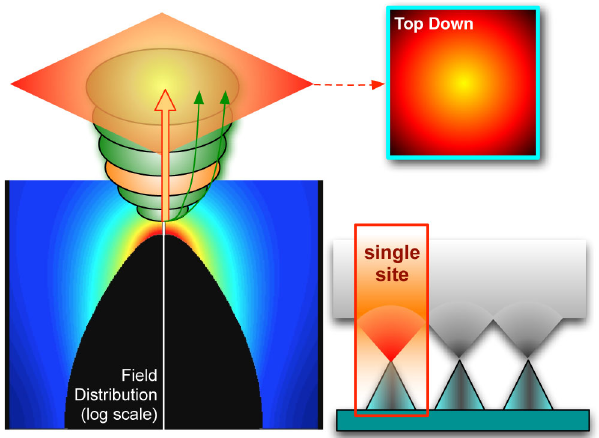
FIG. 22. Sheets of charge in the 1D formulation of space charge effects become disks of charge for emission from portrusions: the disk charge density declines as it moves away from the emission site, reducing the space charge field at the emitter apex by, first, decreasing the charge density of the disk, and second, by introducing an inverse-squared distance dependence. The exam- ple shown is for field emission from a conical